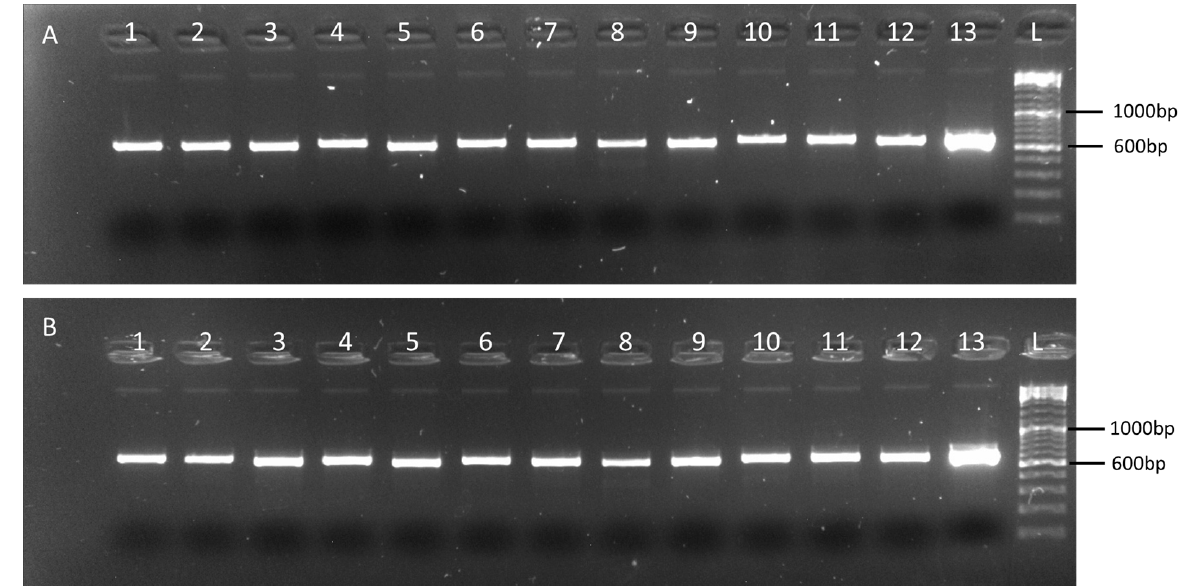
Figure 1. The 600 bp single-plex PCR products for each of the thirteen primers pairs (600-1–600-13, lanes 1 to 13) used to generate overlapping amplicons for tiled amplicon sequencing for ( A ) VPRI43306 and ( B ) NSW3-35. The amplicons were visualised on 1.5% agarose gel with SYBR™ Safe DNA gel stain (Thermo Fisher Scientific, Scoresby, Australia). A 100 bp DNA ladder (Thermo Fisher Scientific Scoresby, Australia) was used for product size estimation.